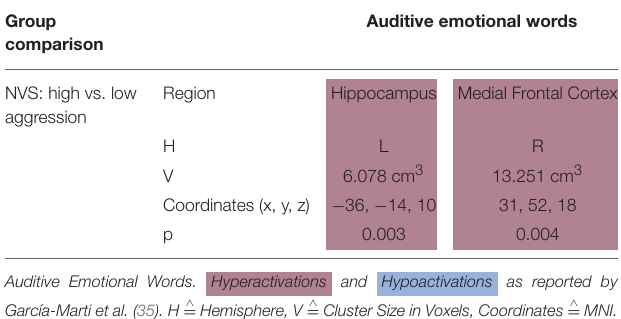
TABLE 5D | Activation patterns in emotion induction: auditive emotional words. Group comparison